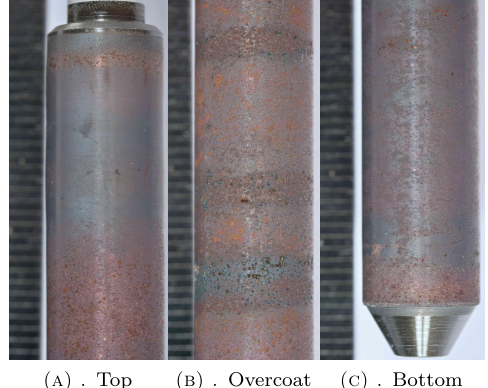
Figure 7. FeCrAl+Mo Run 1 - autoclave temperature and pressure.